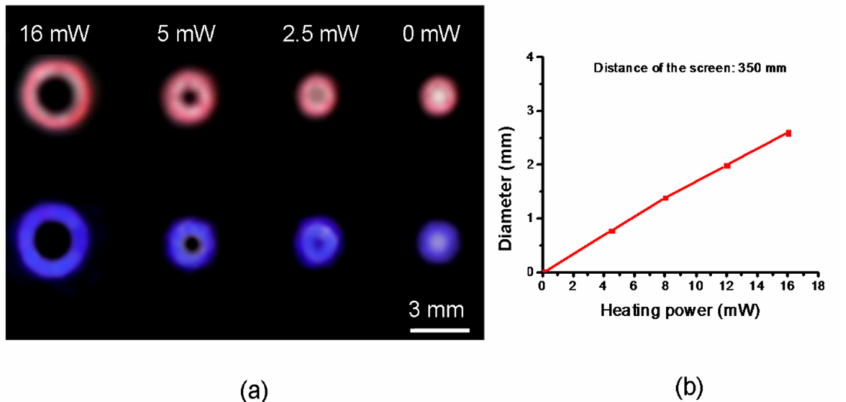
Figure 9. ( a ) Annular rings produced at 350 mm distance from the sample at λ 1 = 633 nm (upper part of the photo) and λ 2 = 405 nm (lower part) for different heating powers. ( b ) The ring diameter, intended as the distance between the maxima directly measured on a diametric scanning line (see caption of Figure 7), vs. the heating power P h .